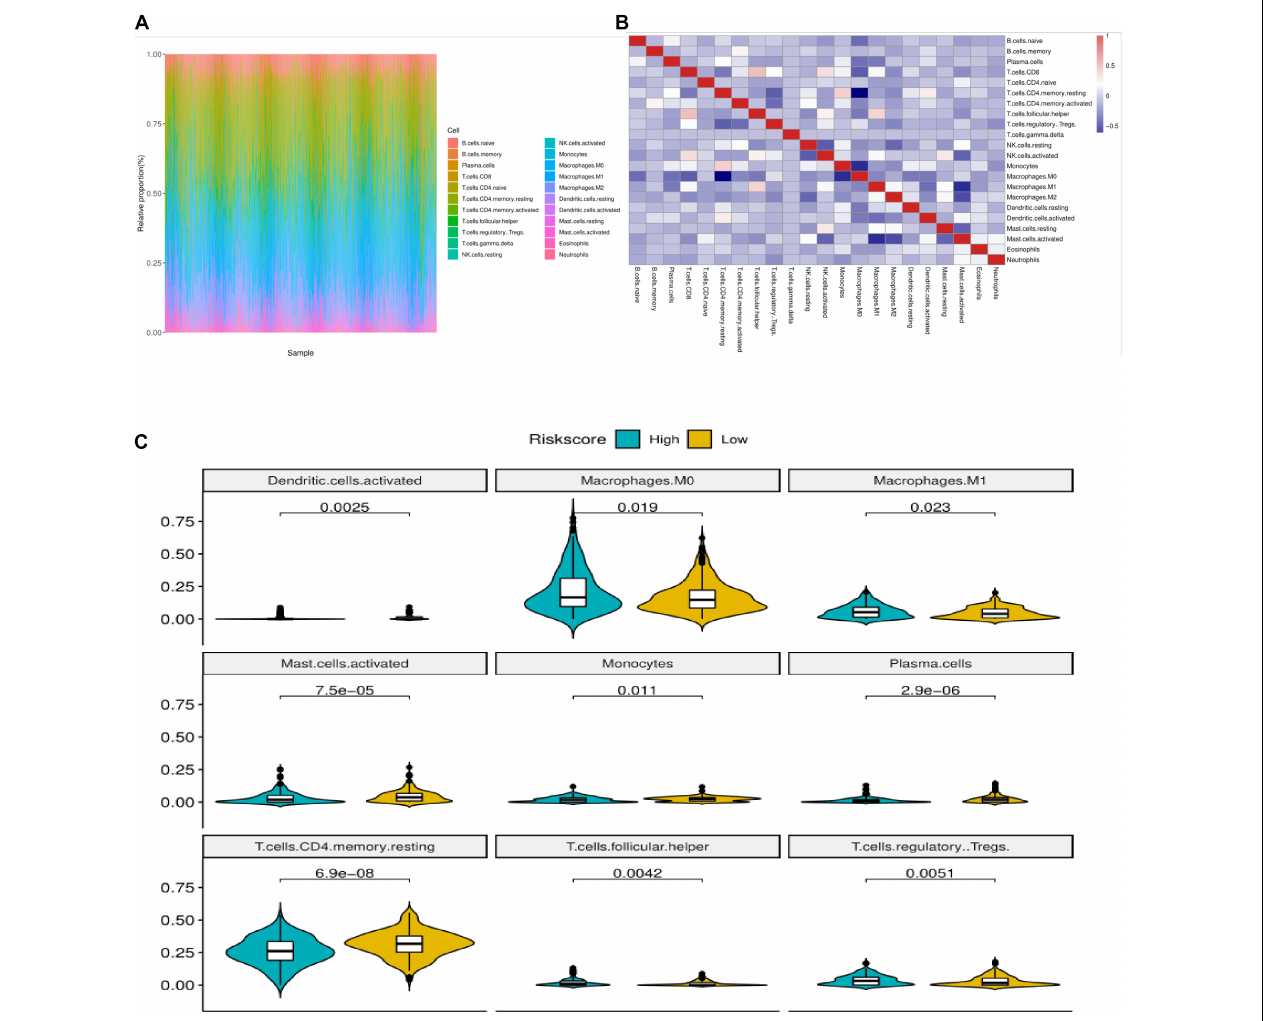
FIGURE 6 | Correlation analysis of immune infiltration in colon cancer patients with high and low risk groups. (A) Relative proportion of immune infiltrating cells in all patients. (B) Correlation matrix of 22 immune cell proportions. Red represents positive correlation. Blue is negative correlation. The deeper the color is, the greater the correlation. (C) The violin diagram of immune cells with significant difference in high and low risk group, the horizontal axis is high and low risk group, the longitudinal axis is the relative infiltration ratio of immune cells, and the p -value is calculated by wilcoxn